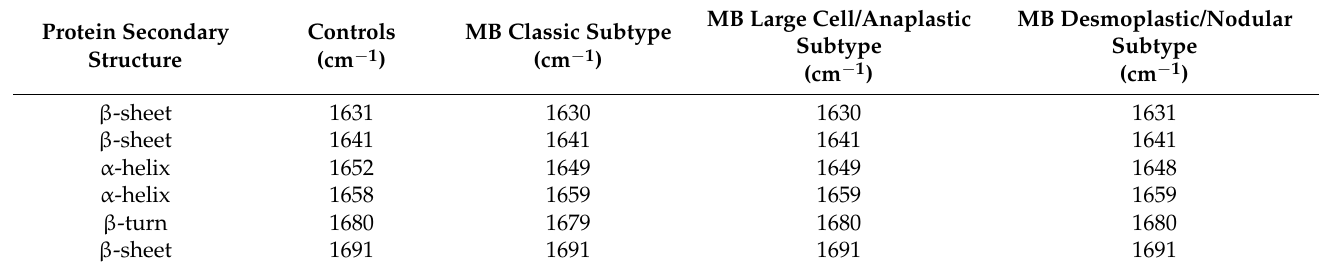
Table 2. Assignment of amide I band position to secondary structure of